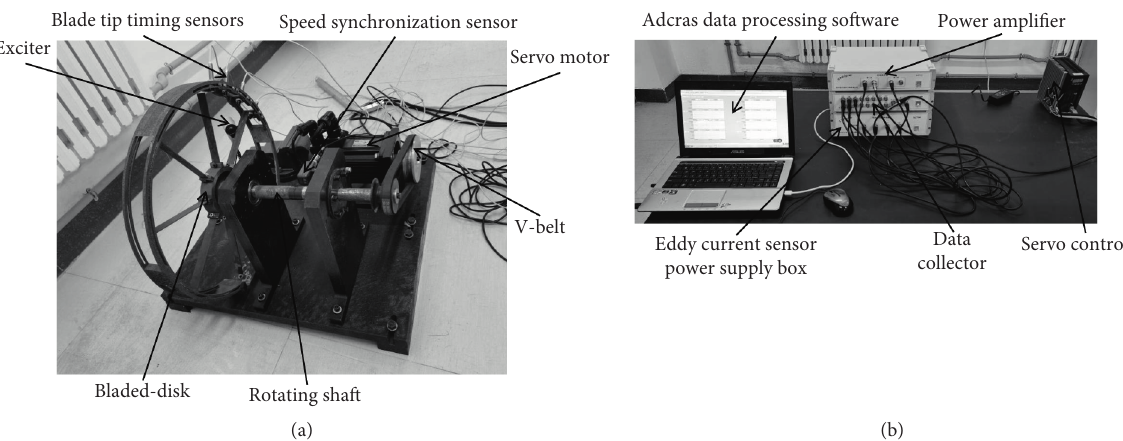
Figure 8: BTT measurement experiment bench. (a) Rotating blade noncontact measurement device. (b) Signal acquisition and data processing